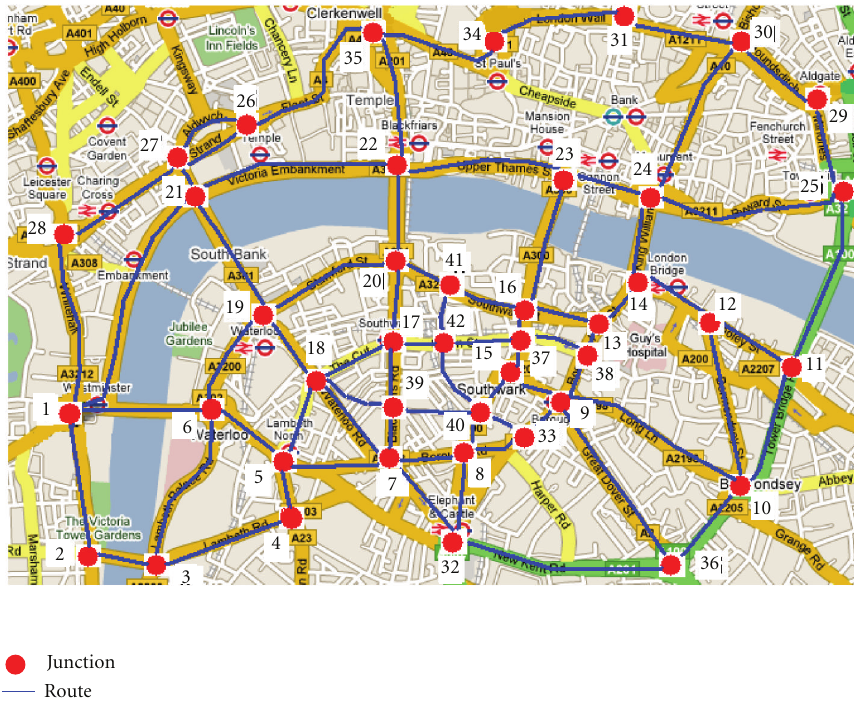
Figure 12: Selected region of London, UK, for simulations consisted of 42 junctions.